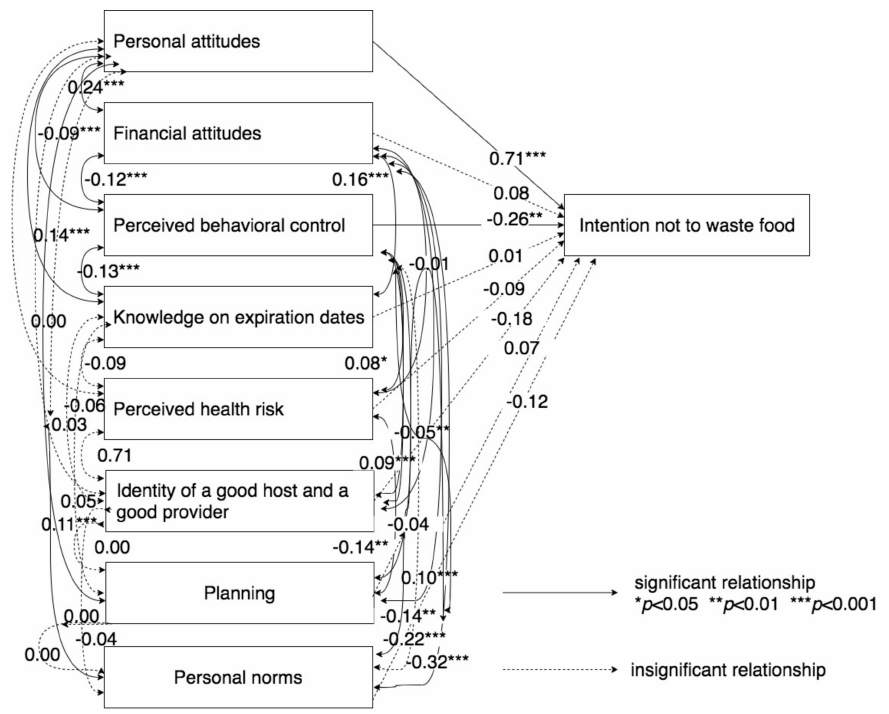
Figure 2. The intention not to waste food in the general model. Full lines mean significant relationship; dotted lines mean insignificant relationship; * p < 0.05; ** p < 0.01; *** p <